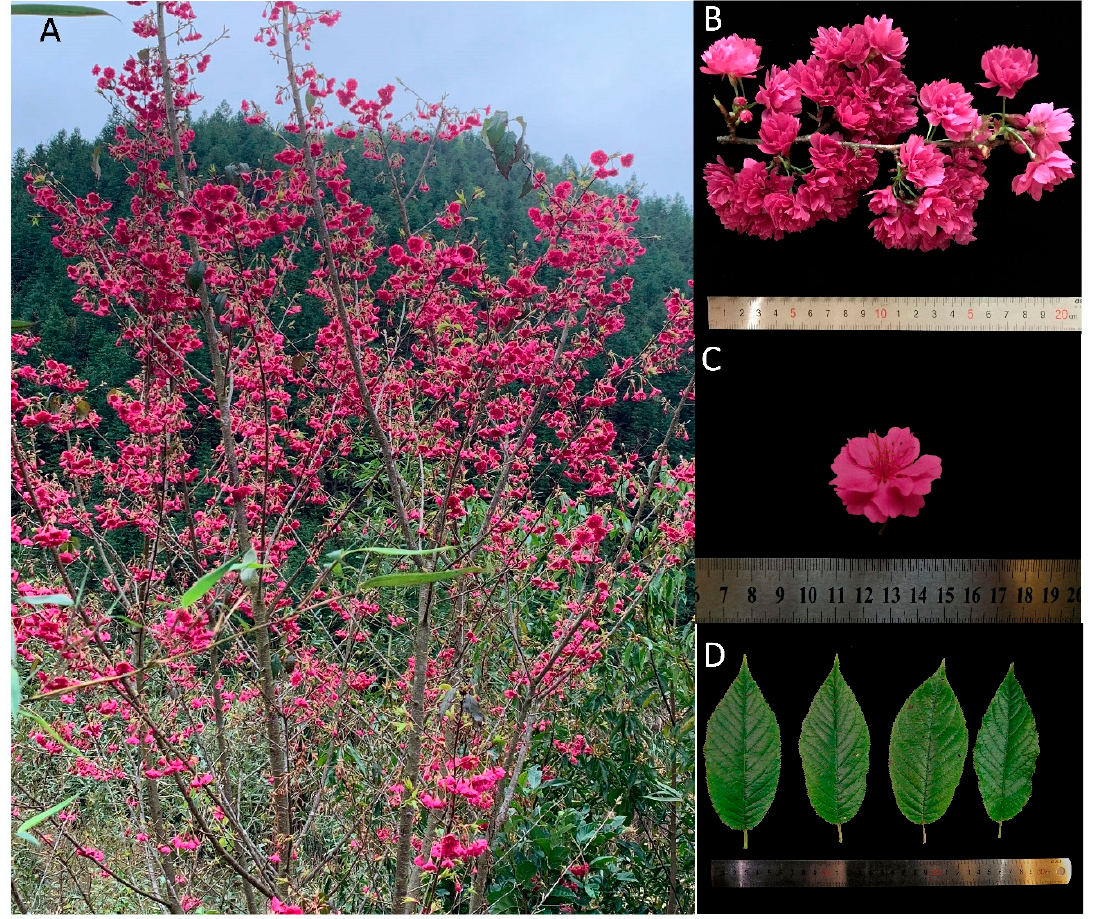
Figure 1. Morphology of P. campanulata cultivar “Lianmeiren”. ( A ) P. campanulata tree grows in Shaowu City, Fujian Province. ( B ) Flower branch and inflorescence. ( C ) Flower. ( D ) Leaves. The scale unit of the ruler is a